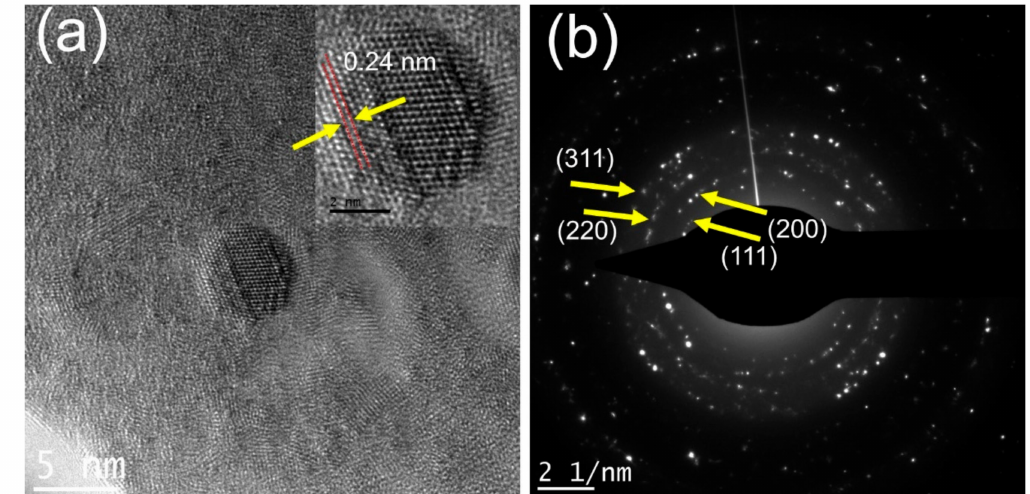
Figure 2. TEM images of Algae-AgNPs prepared by nanoprecipitation of 3:7 v / v of algae 0.1 M AgNO 3 / plant extract on the holey carbon grid. ( a ) HRTEM image of the Algae-AgNP showing the spherical morphology and crystalline nature of typical 5 nm NP. The inset is showing a magnified view of the NP. ( b ) Selected area electron di ff raction (SAED) pattern showing the polycrystalline nature of